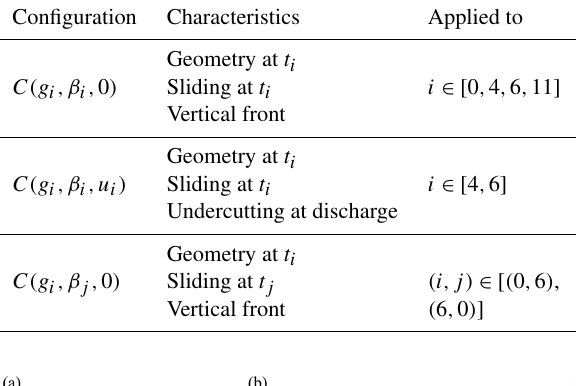
Table 2. Different configurations, C , characteristics and periods. Configuration